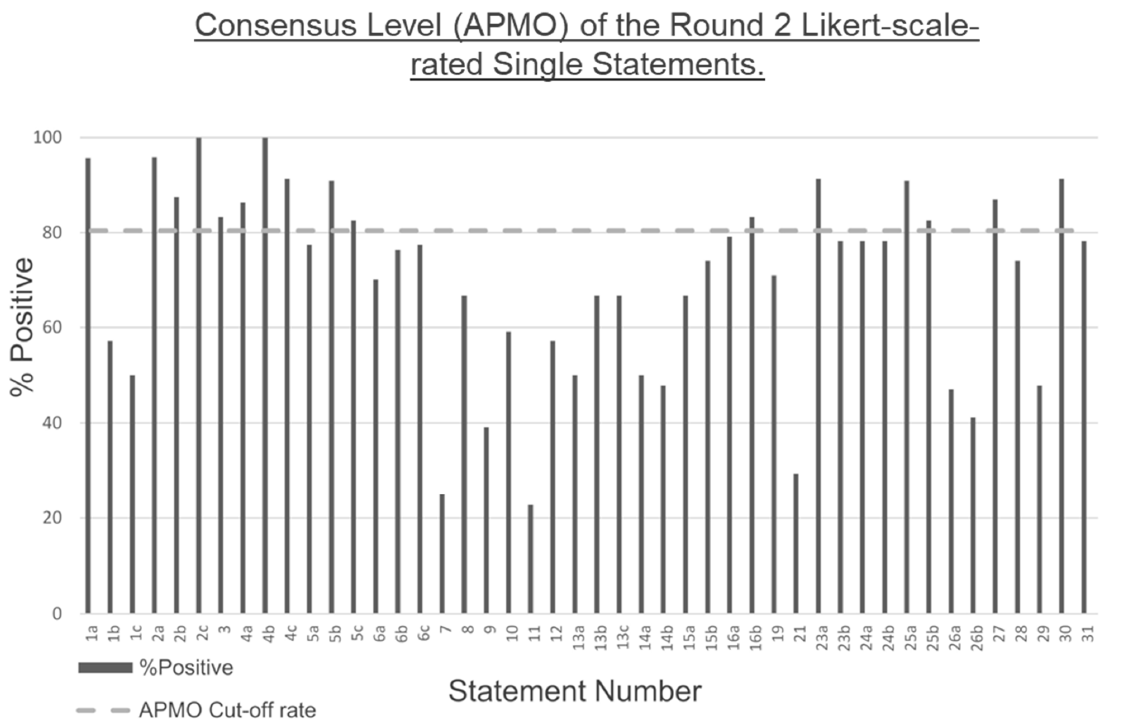
Figure 4. The Likert-scale-rated single statements with an APMO above that of the APMO cut-off rate in round 2 (80.43%; dashed line).